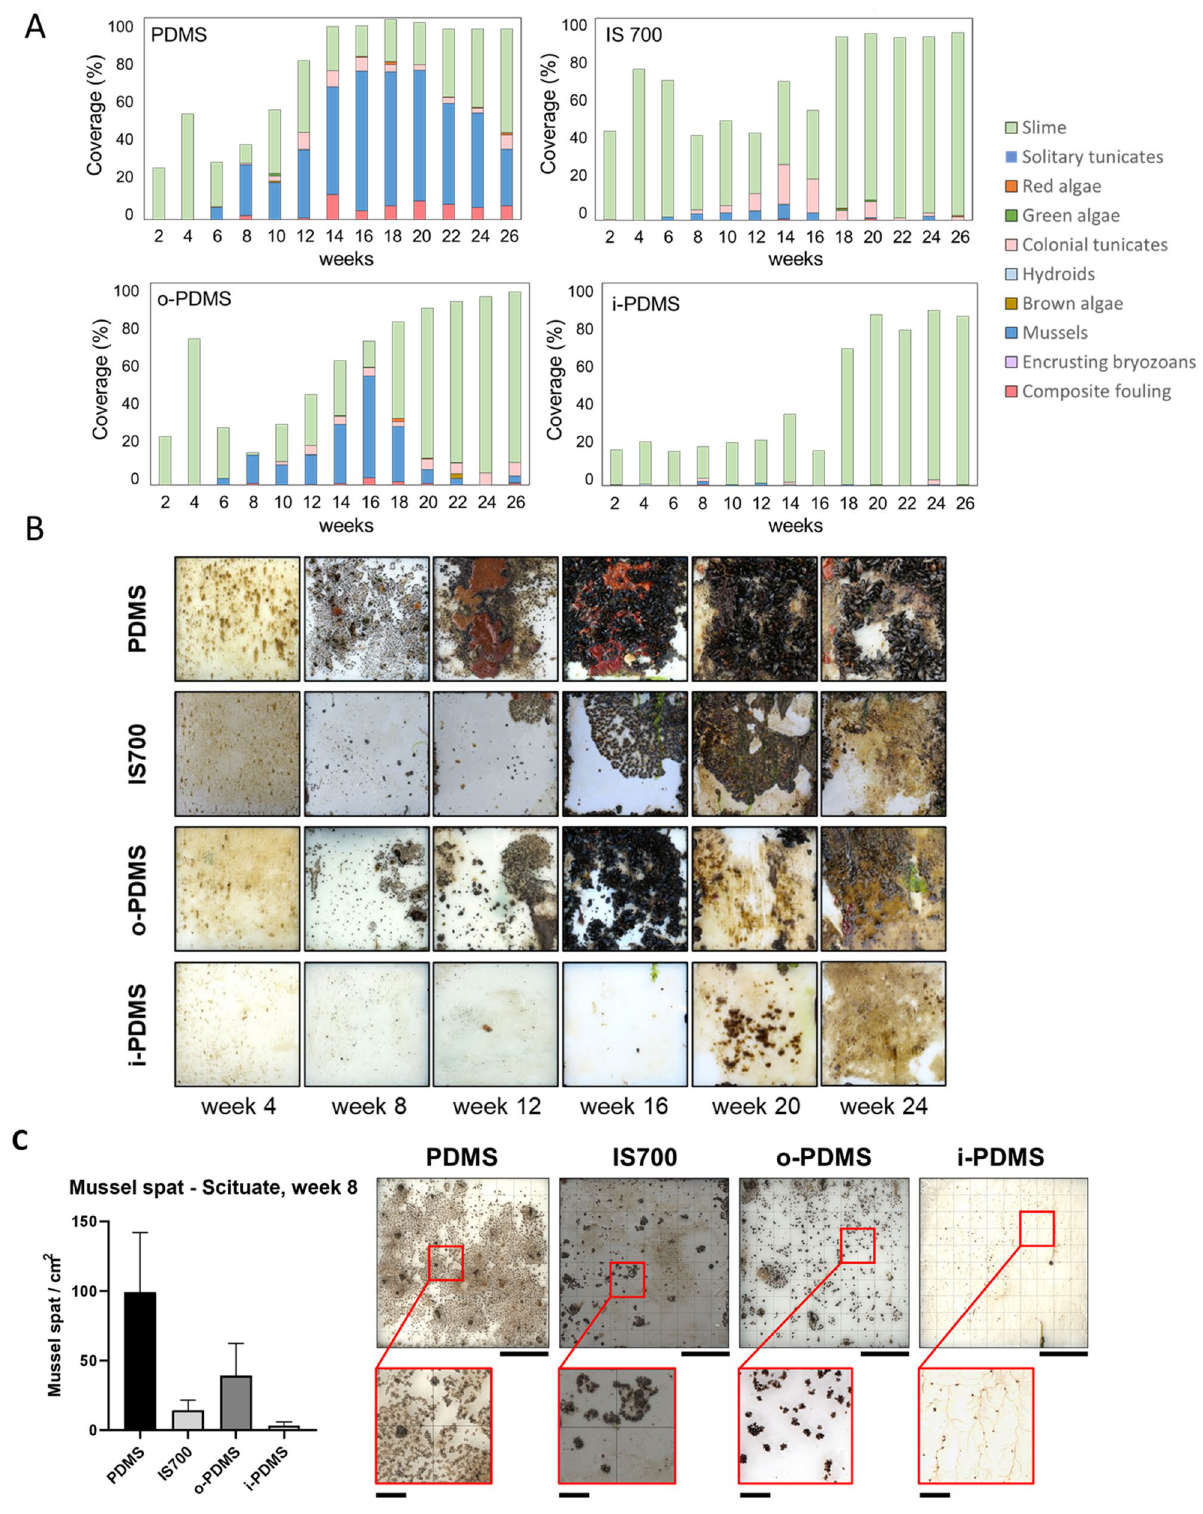
Figure 3. ( A ) Fouling coverage and composition on PDMS control, Intersleek 700 (IS700), o-PDMS and i-PDMS over a 6-month emersion period at Scituate Harbor, MA. Composite fouling = the combination of hard and soft fouling organisms growing on top of another, this is considered to be the heaviest, most problematic fouling category. ( B ) Representative images of the treated panels (17.5 cm × 17.5 cm) showing the fouling trends observed on each coating. Number of samples for each coating type (N) = 5. ( C ) Mussel spat densities on PDMS, IS700, o-PDMS and i-PDMS treatments in week 8. Error bars = standard deviation (SD) with presentative images on the mussel spat accumulation patterns on each treatment type. Note that on i-PDMS surface, mussel spat generally forms on remnants of the retracted biofilm, as shown in insets. Full panel scale bar = 5 cm, inset scale bar = 1 cm, number of samples (N) =